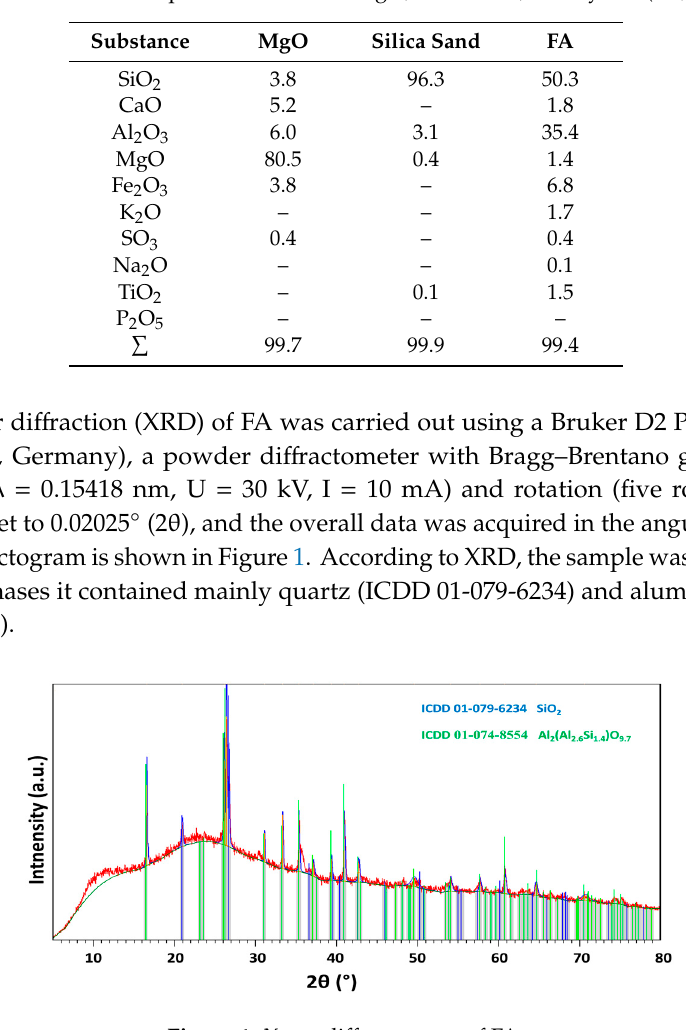
Figure 1. X-ray diffractogram of FA. Figure 1. X-ray di ff ractogram of